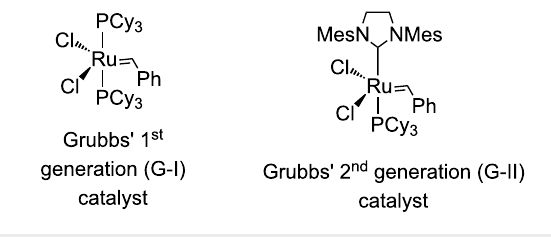
Figure 1: Commercially available ruthenium catalysts used in RRM metathesis.